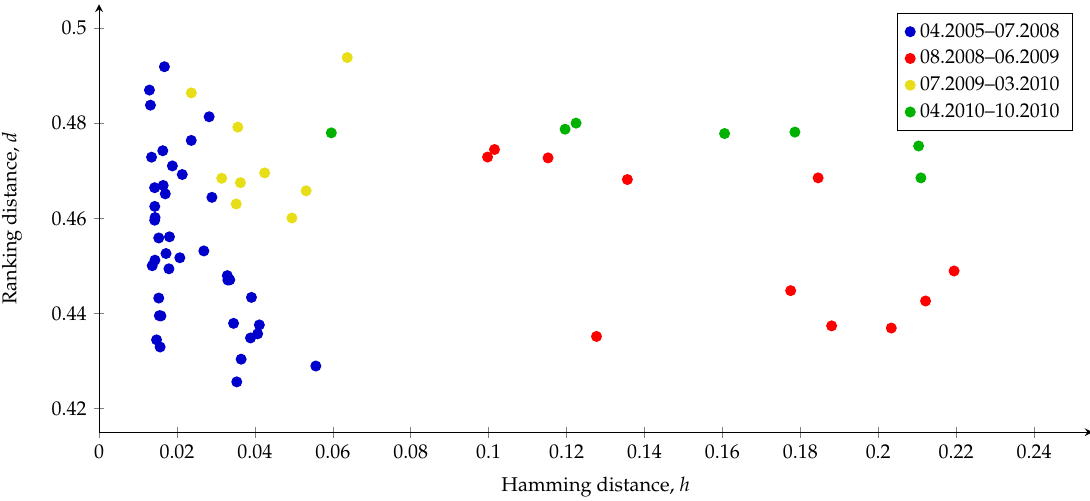
Figure 5. The evolution of the ranking and the Hamming distances between the co-mention networks and the market graphs constructed for the same period of